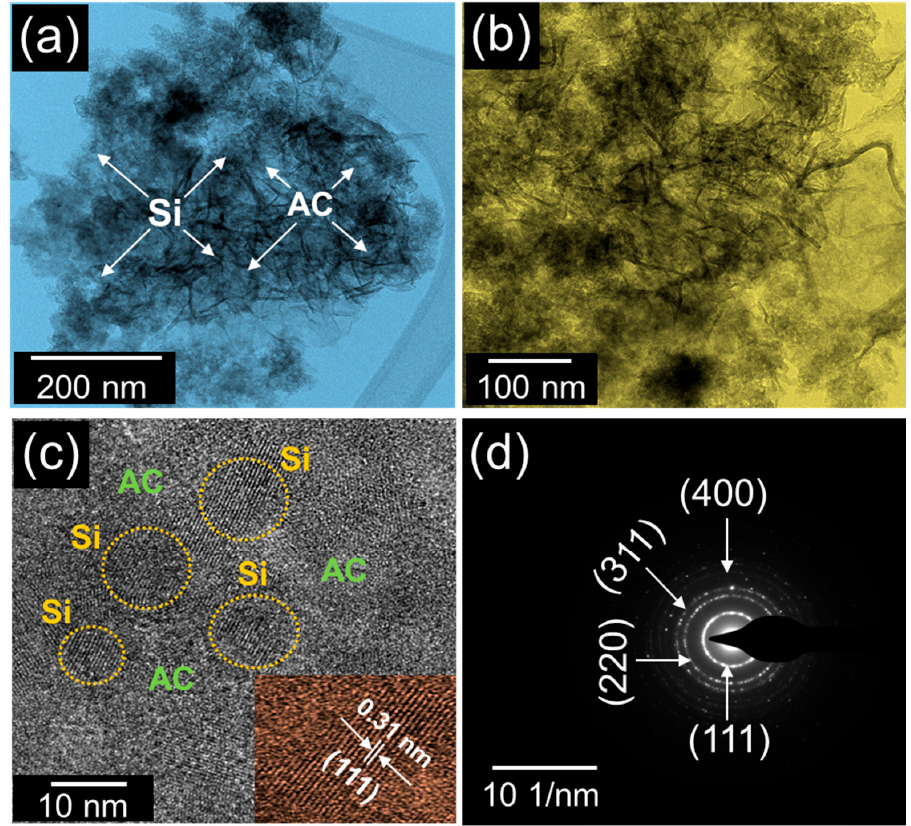
Figure 4. ( a ) Low-magnification TEM image, ( b ) high-magnification TEM image, ( c ) high-resolution TEM image, and ( d ) SAED patterns of the C-Si nanocomposites.